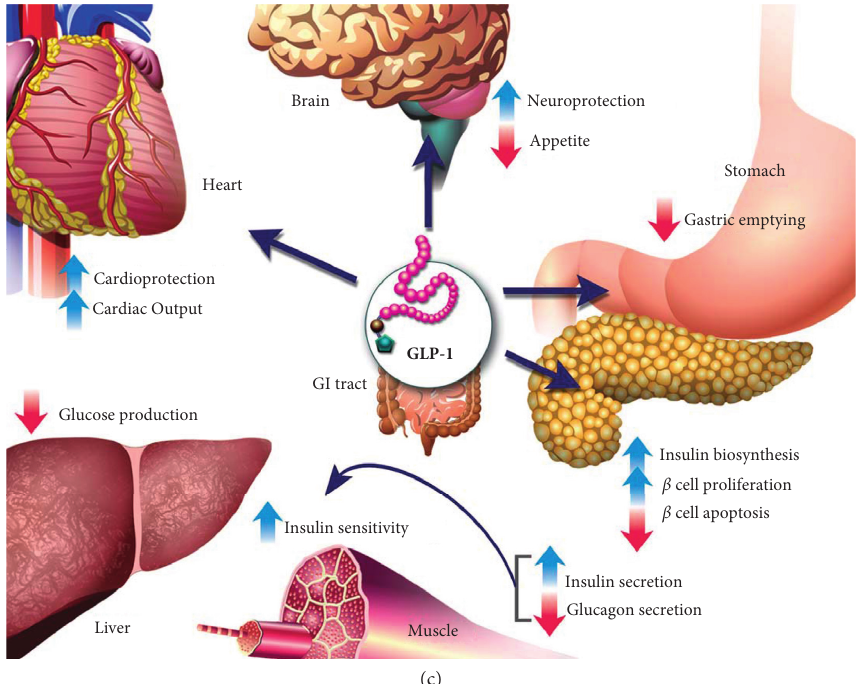
Figure 1: Mechanism of action of diabetes medications on multiple organ systems: (a) SGLT2 inhibitors [1]; (b) DPP-4 inhibitors [2]; (c) GLP-1 agonists